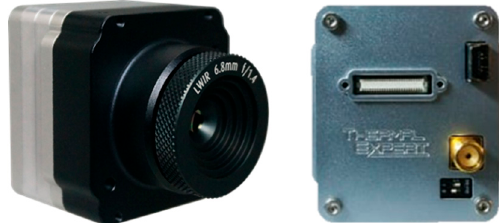
Figure 9. Single-lens reflex camera.